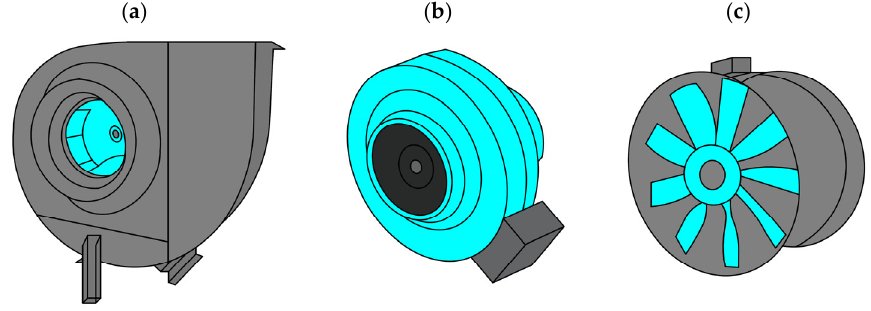
Figure 5. Types of fans: ( a ) radial fan, ( b ) duct fan—with a radial rotor, ( c ) axial fan.